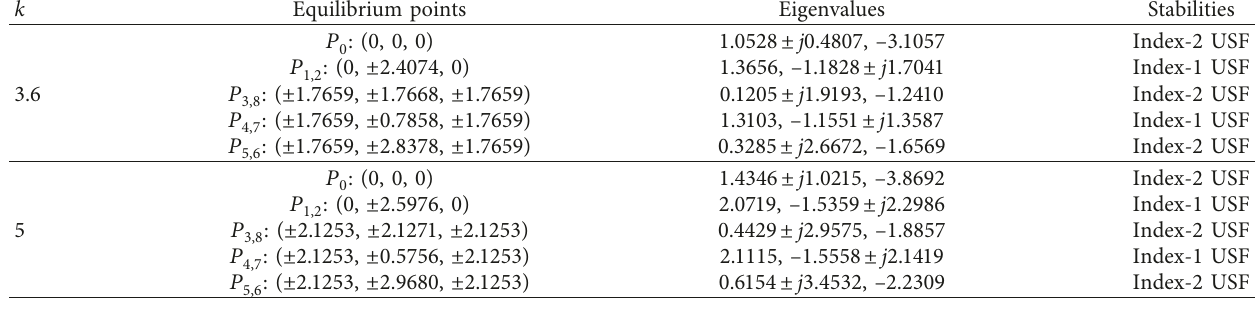
1 and h 2 described by (5) and (6). 3.6 and 5. (cid:31)